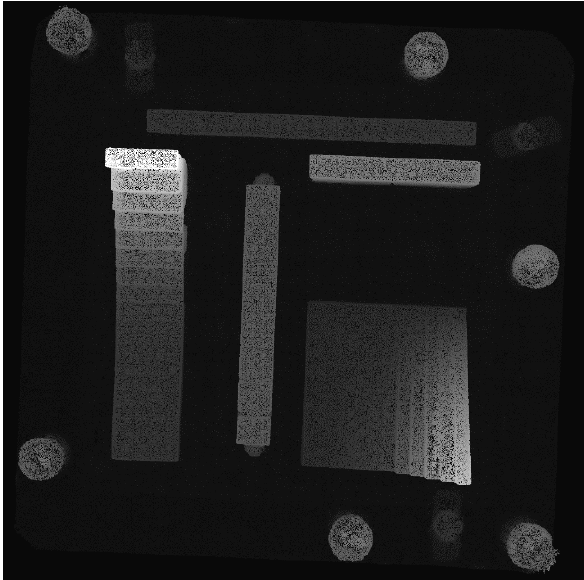
Figure 14. Point cloud from Dense Matcher projected to DEM by camera geometry, before